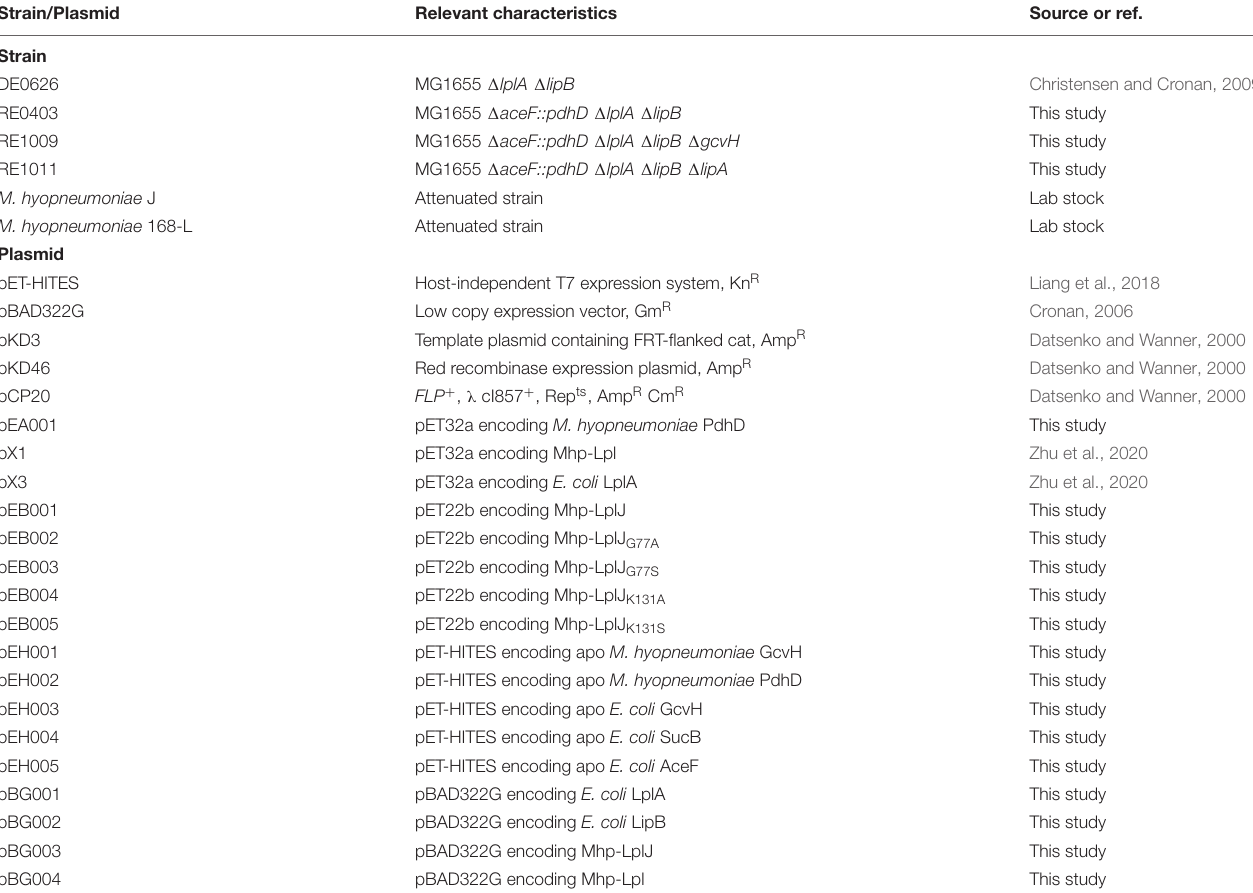
TABLE 1 | Strains and plasmids used in this work. Strain/Plasmid Relevant